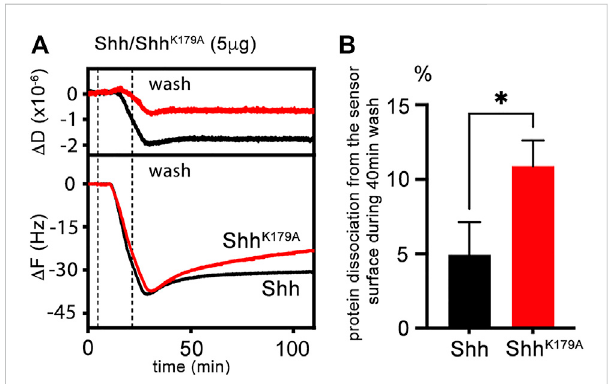
FIGURE 6 QCM-D measurements of untagged Shh interactions with heparin. (A) Schematic representation and real-time analysis of Shh binding to the functionalized QCM-D sensor surface assembled on a silica surface. The supported lipid bilayer exposes heparin to represent the HS model matrix. Shh binding decreases Δ F during the protein incubation step and decreases Δ D correspondingly, demonstrating protein binding and decreased softness of the functionalized matrix. Similar Shh K179A loading of the functionalized matrix (- Δ F about − 40 Hz in both cases) is associated with a less negative Δ D. The most parsimonious explanation for matrix softening is that Shh cross-links its components and that K179 of the second HS binding site participates in the process. Removal of this amino acid in Shh K179A results in increased protein loss from the QCM-D sensor surface into the wash buffer (red line). (B) Graphical representation of Shh and Shh K179A elution. Unpaired t -test, results from three (Shh K179A ) and four (Shh) independent experiments are shown. *: p = 0.011. See Supplementary Table S2 for exact statistical